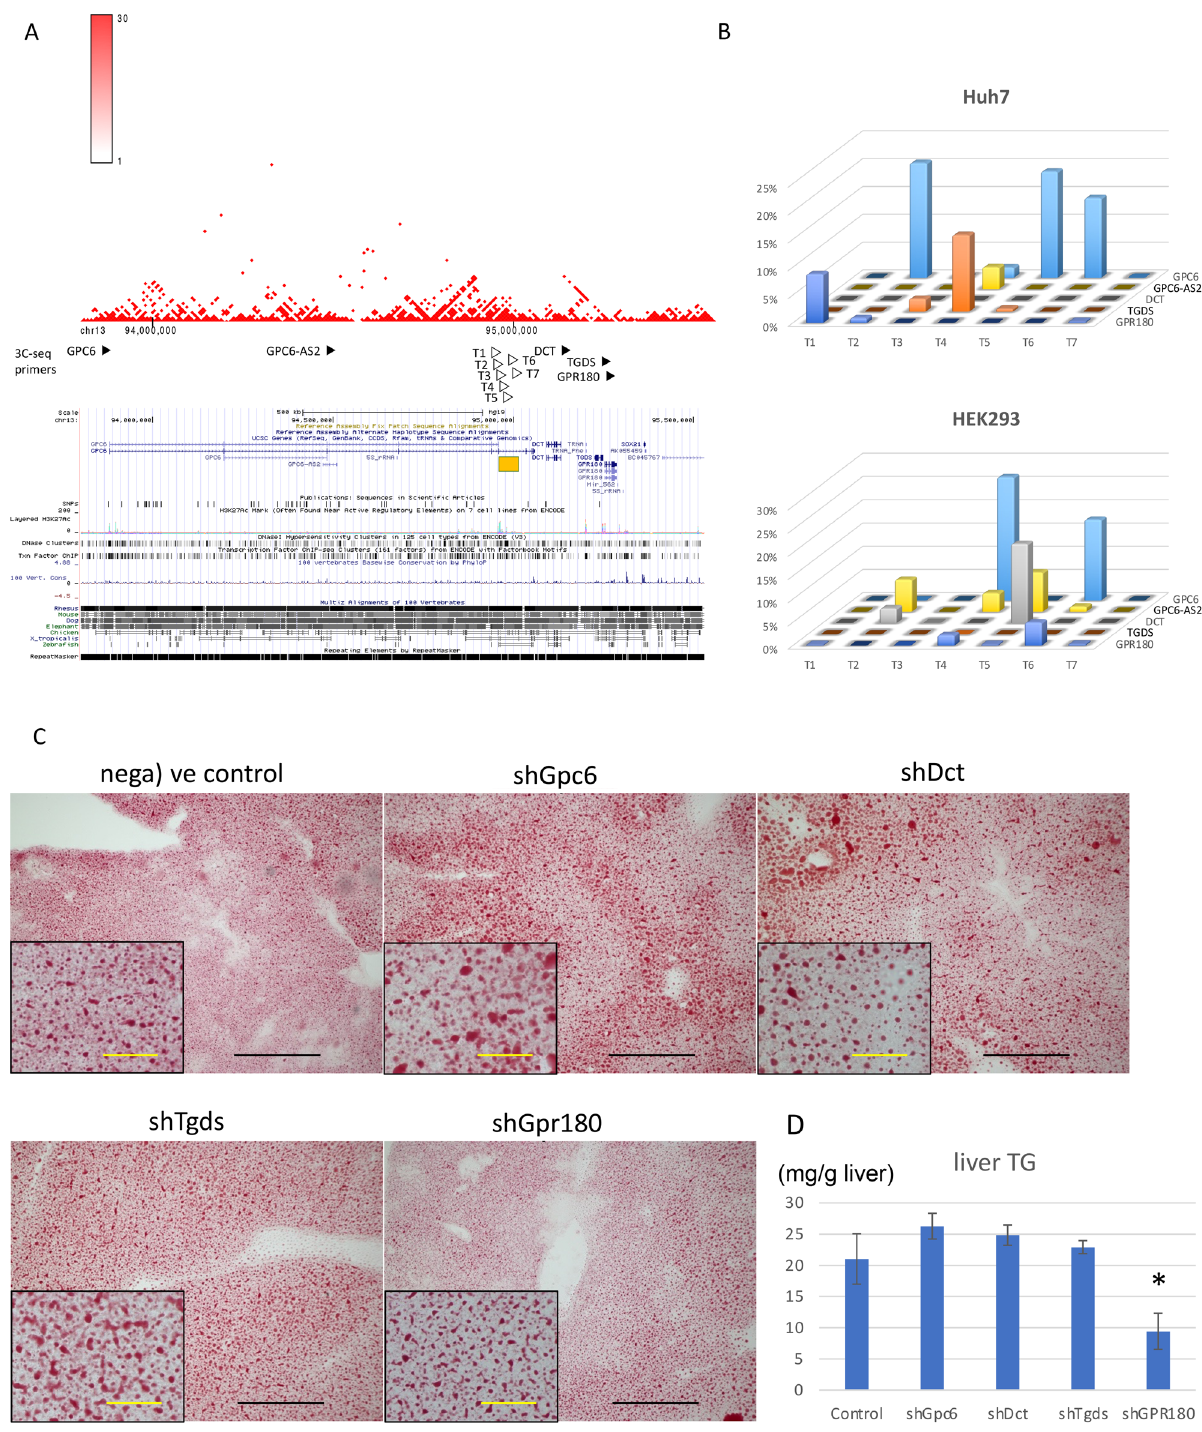
Figure 1. Bioinformatics and functional assessment of genetic association signals. ( A ) Bioinformatics data of HiC and ENCODE databases were merged on the identical chromosomal position around the GWAS association peak on chr13 (yellow bar). Open and closed triangles indicate the primer position used in the chromosome conformation capture assay (3C-assay). ( B ) Relative quantification of the 3C-assay. Crosslinked nuclei of Huh7 and HEK293 cells were digested with Mbo I and intermolecularly ligated. The ligation products were quantified using low cycle-PCR and subsequent pair-end MiSeq sequencing. Three-dimensional bar graphs show the relative amounts of PCR products amplified by the primer sets indicated in the X and Y axes. ( C ) Knockdown screening of the four coding genes. AAV8 vectors encoding shRNA templates for Gpc6, Dct, Tgds, Gpr180 or negative control vector were injected into the tail vein of C57B6 mice. The vector-injected mice were fed with MCDD for one week. The extracted liver sections were stained by Oil Red O. Black and yellow scale bars indicate 100 and 20 μm, respectively. ( D ) Triglyceride (TG, mg/g liver) contents in the liver of each vector- injected group. Data are presented as means with standard deviation (n = 4 per AAV vector). *p <